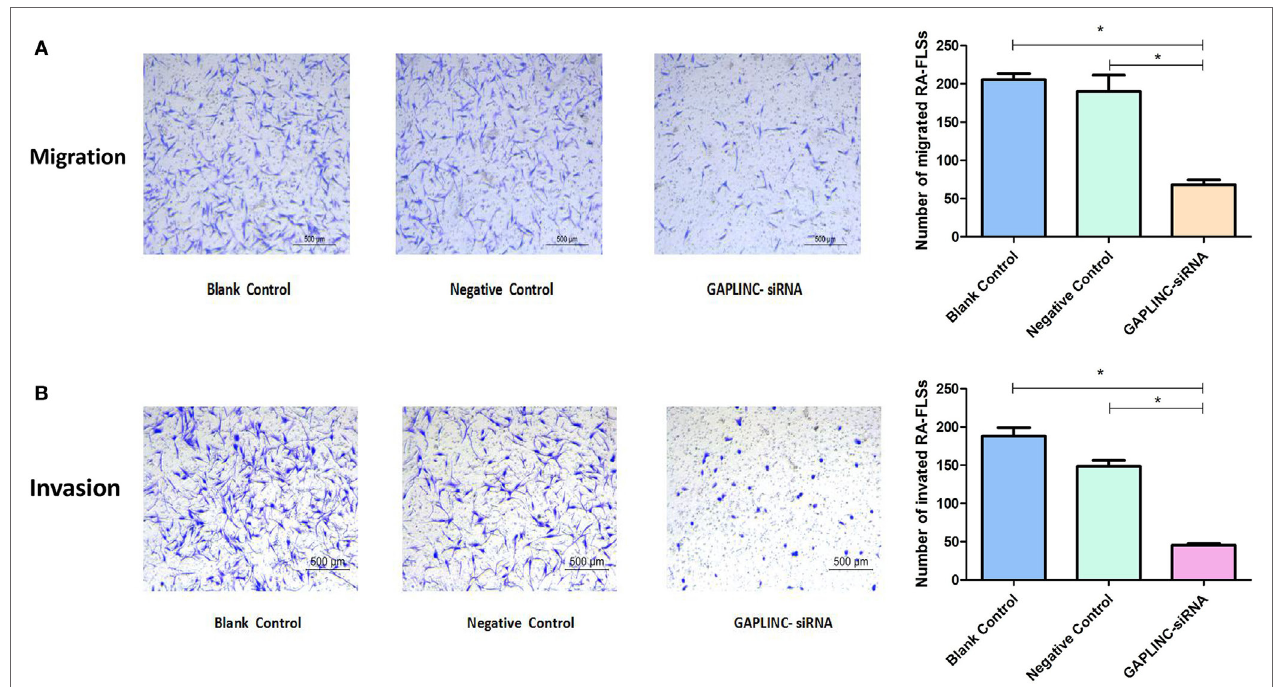
FigUre 3 | Knocking-down GAPLINC in rheumatoid arthritis (RA)-fibroblast-like synoviocytes impaired cell migration and invasion ability. The migration and invasion in RA-FLS were examined, respectively, by Transwell assay and Matrigel Transwell assay. In both (a,B) , left panels show representative images of transmembrane cells; right panels present quantification (means ± SD) of different groups, * P <